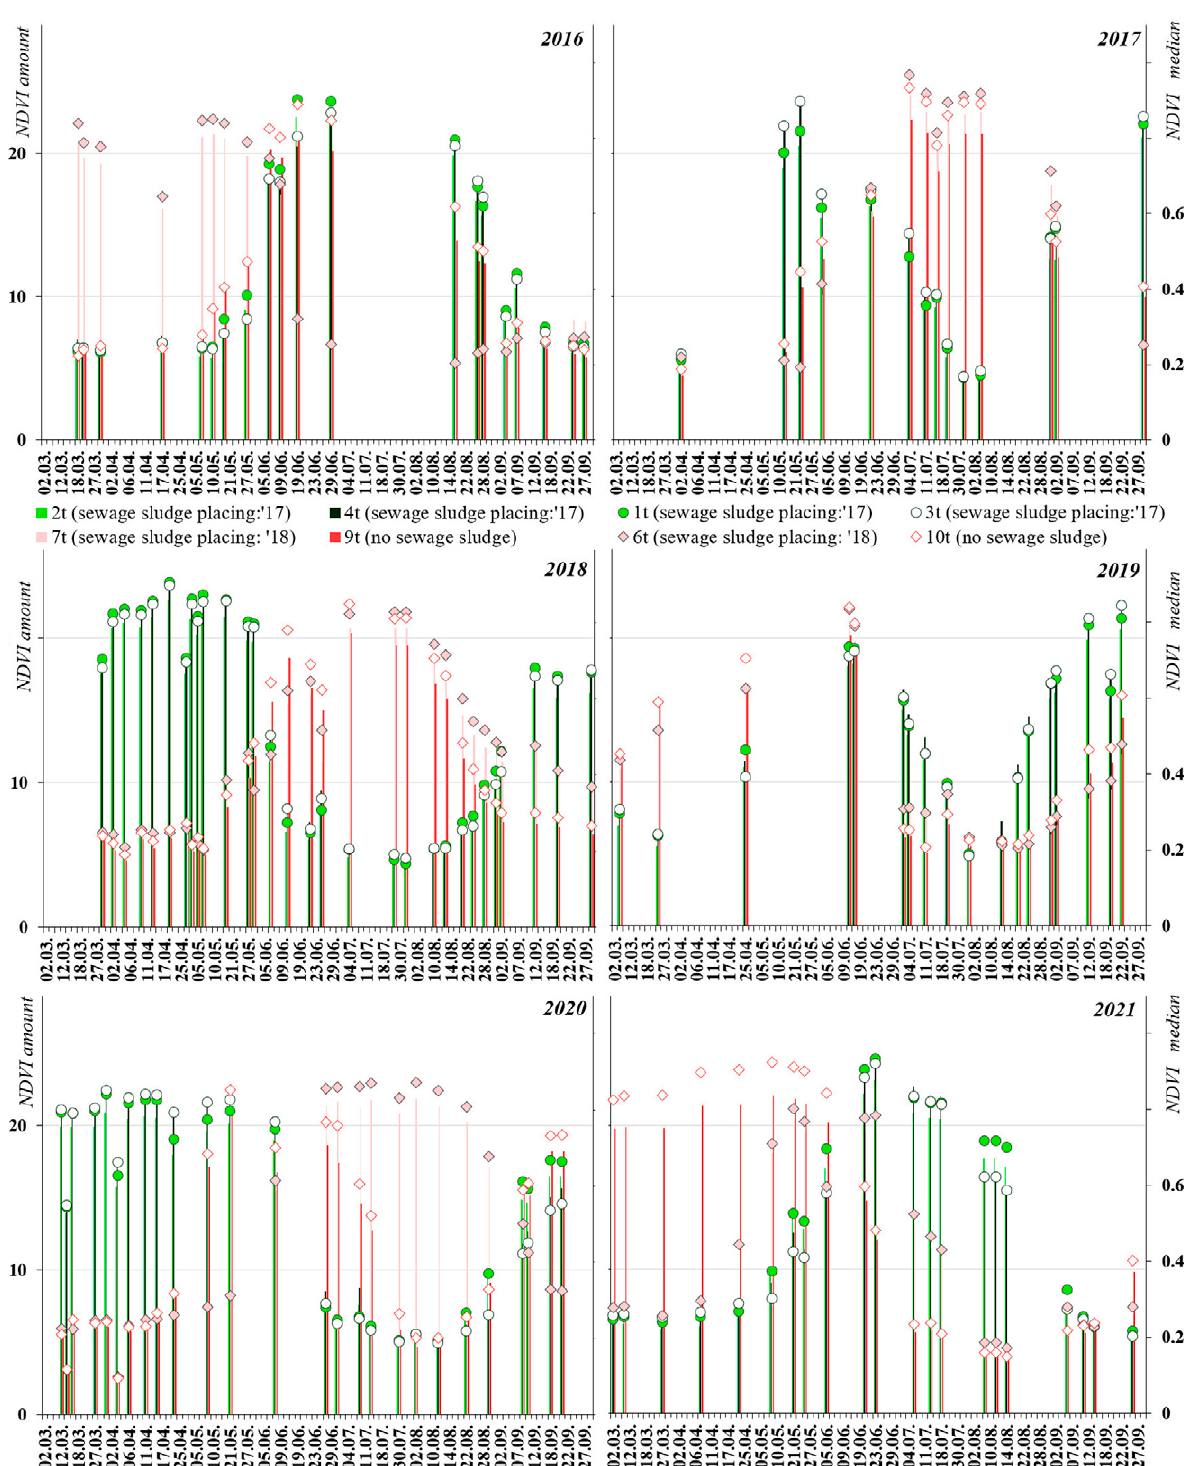
Figure 3. NDVI values of quadrates of Újkígyós study site between 2016 and 2021 (points: NDVI median, columns: NDVI total) (1t-4t: sewage sludge placing in 2017; 6t-7t: sewage sludge placing in 2018; 9t-10t: no sewage